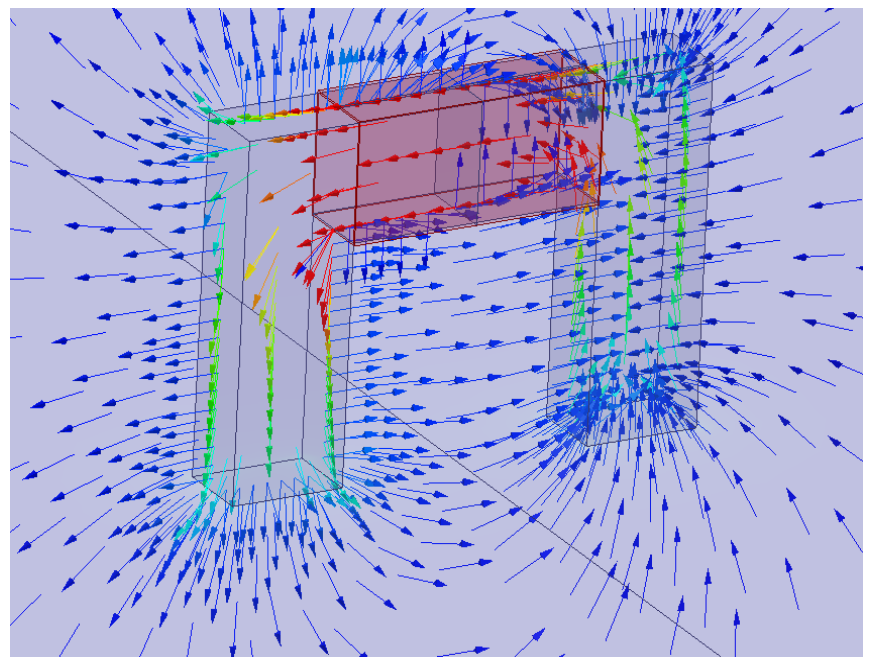
Figure 2. Single winding probe: flux density predicted by FEM